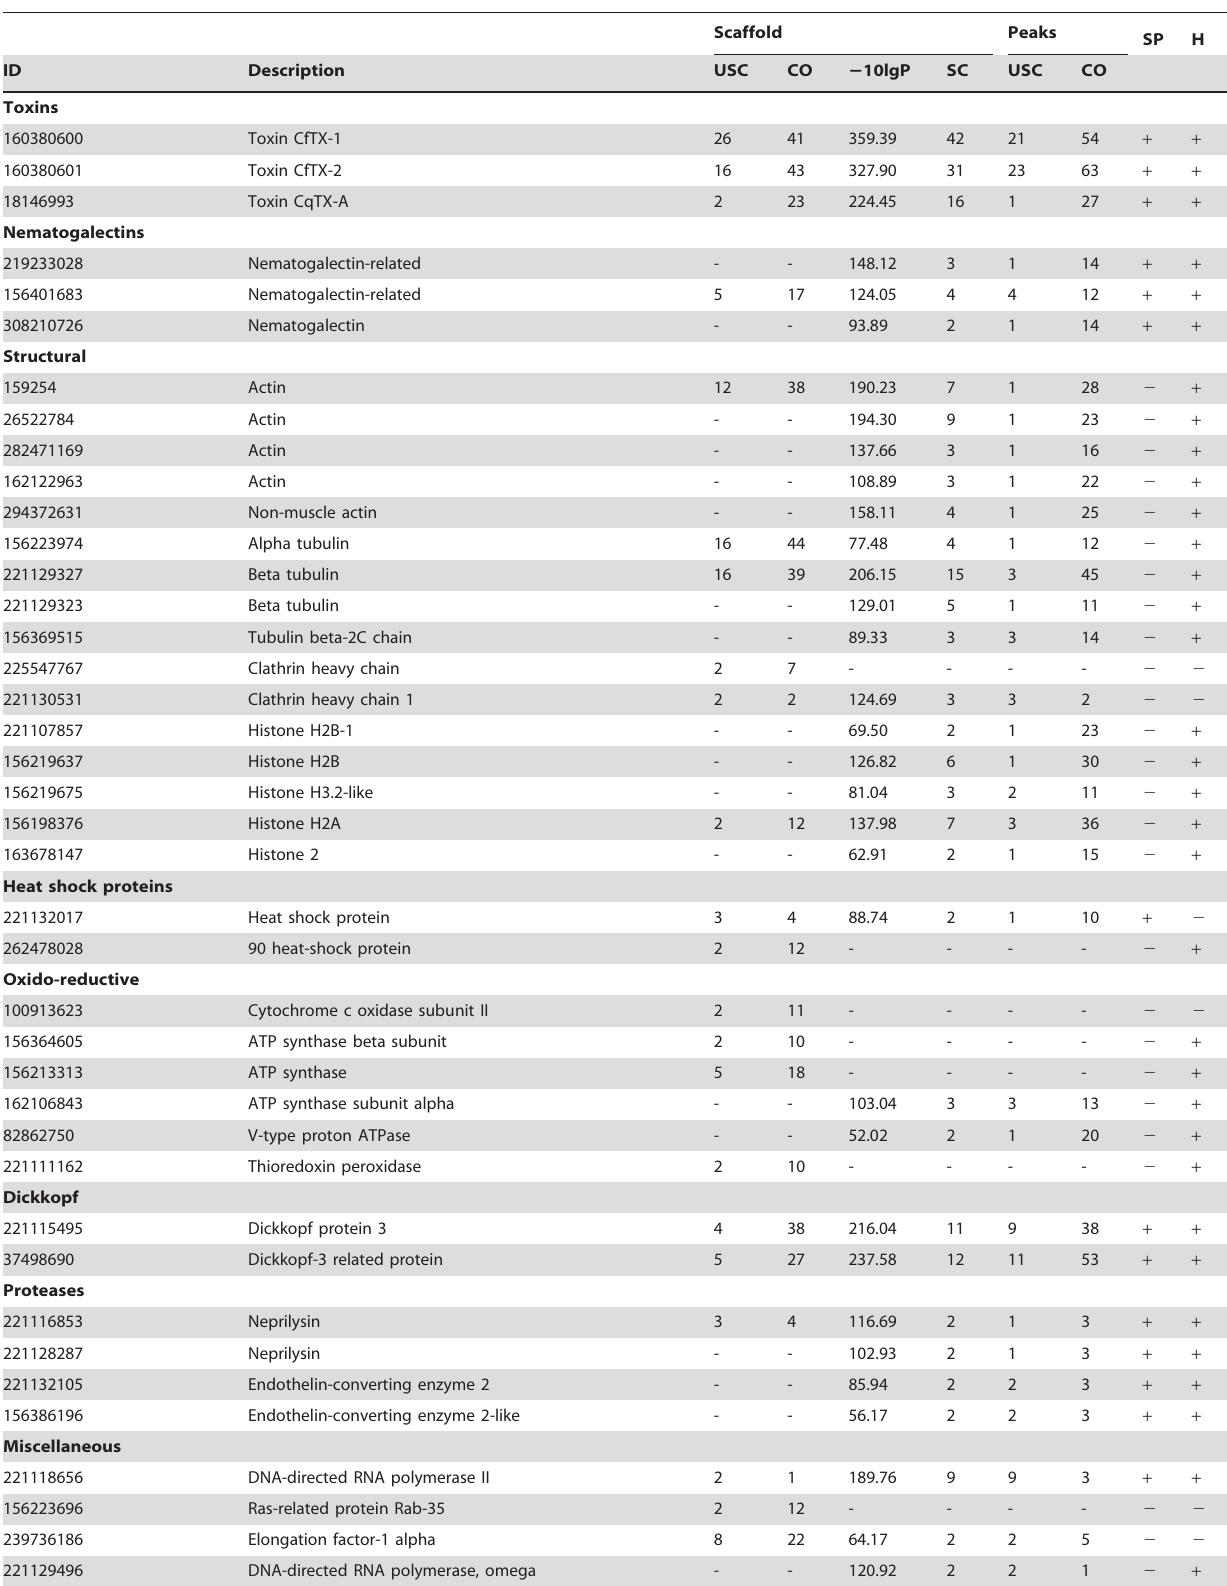
Table 1. Protein identifications using Mascot and